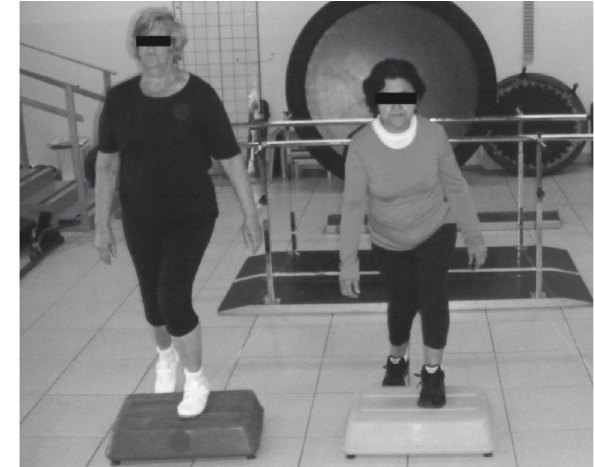
Figura 6 - Demonstração dos exercícios de cadeia cinética fechada (step) na FT Fonte: Dados da